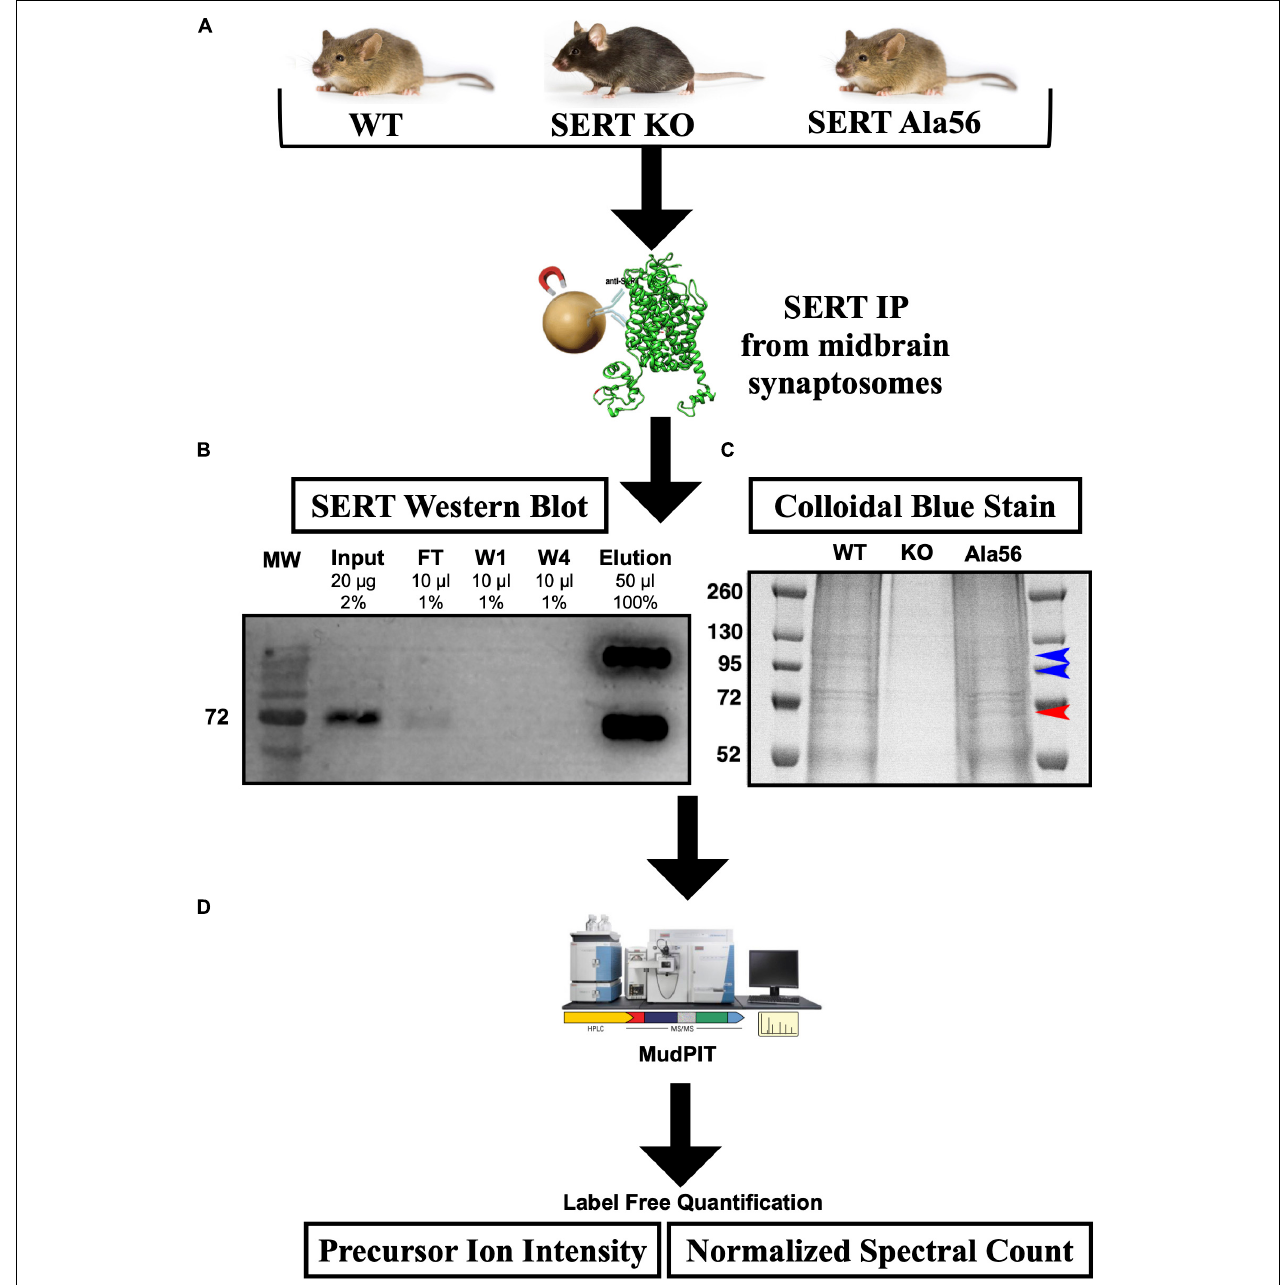
FIGURE 1 | SERT co-immunoprecipitation followed by LC-MS/MS. (A) Midbrain synaptosomes from WT, SERT KO (negative control), and SERT Ala56 mice were affinity purified for SERT ( n = 3). (B) Western blot confirms efficient SERT IP (MW = Molecular Weight; FT = Flow Through; W1 = Wash 1; W4 = Wash 4). (C) Colloidal-blue stain of proteins eluted from SERT IP confirms altered protein association profiles (red and blue arrow indicate increase and decrease, respectively, protein band intensities in SERT Ala56 compared to WT). (D) In-gel tryptic digestion was followed by an 8 step MudPIT. Eluting peptides were mass analyzed on an LTQ Orbitrap Velos (Thermo Scientific). Scaffold (version 4.7.3) was used to validate MS/MS based peptide and protein identifications.